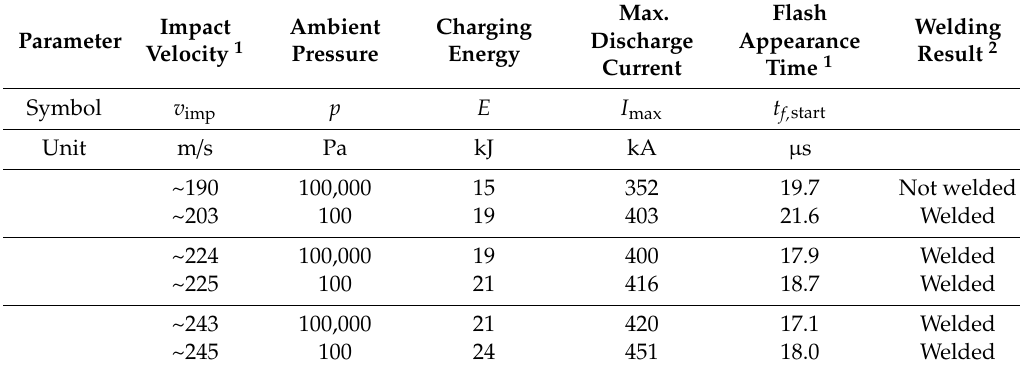
Table 4. Influence of the impact velocity and ambient pressure on the welding result.